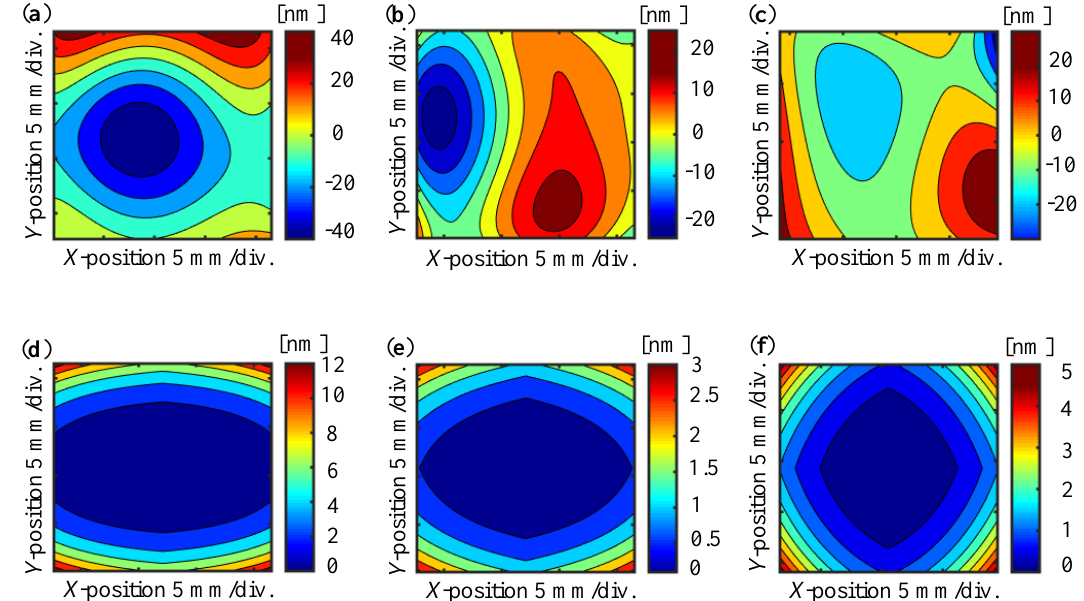
Figure 12. Error and uncertainty maps of the planar scale grating. ( a ) Error map of the Z -directional out-of-flatness; ( b ) Error map of the X -directional pitch deviation; ( c ) Error map of the Y -directional pitch deviation; ( d ) Uncertainty map of the Z -directional out-of-flatness; ( e ) Uncertainty map of the X -directional pitch deviation; and, ( f ) Uncertainty map of the Y -directional pitch deviation.